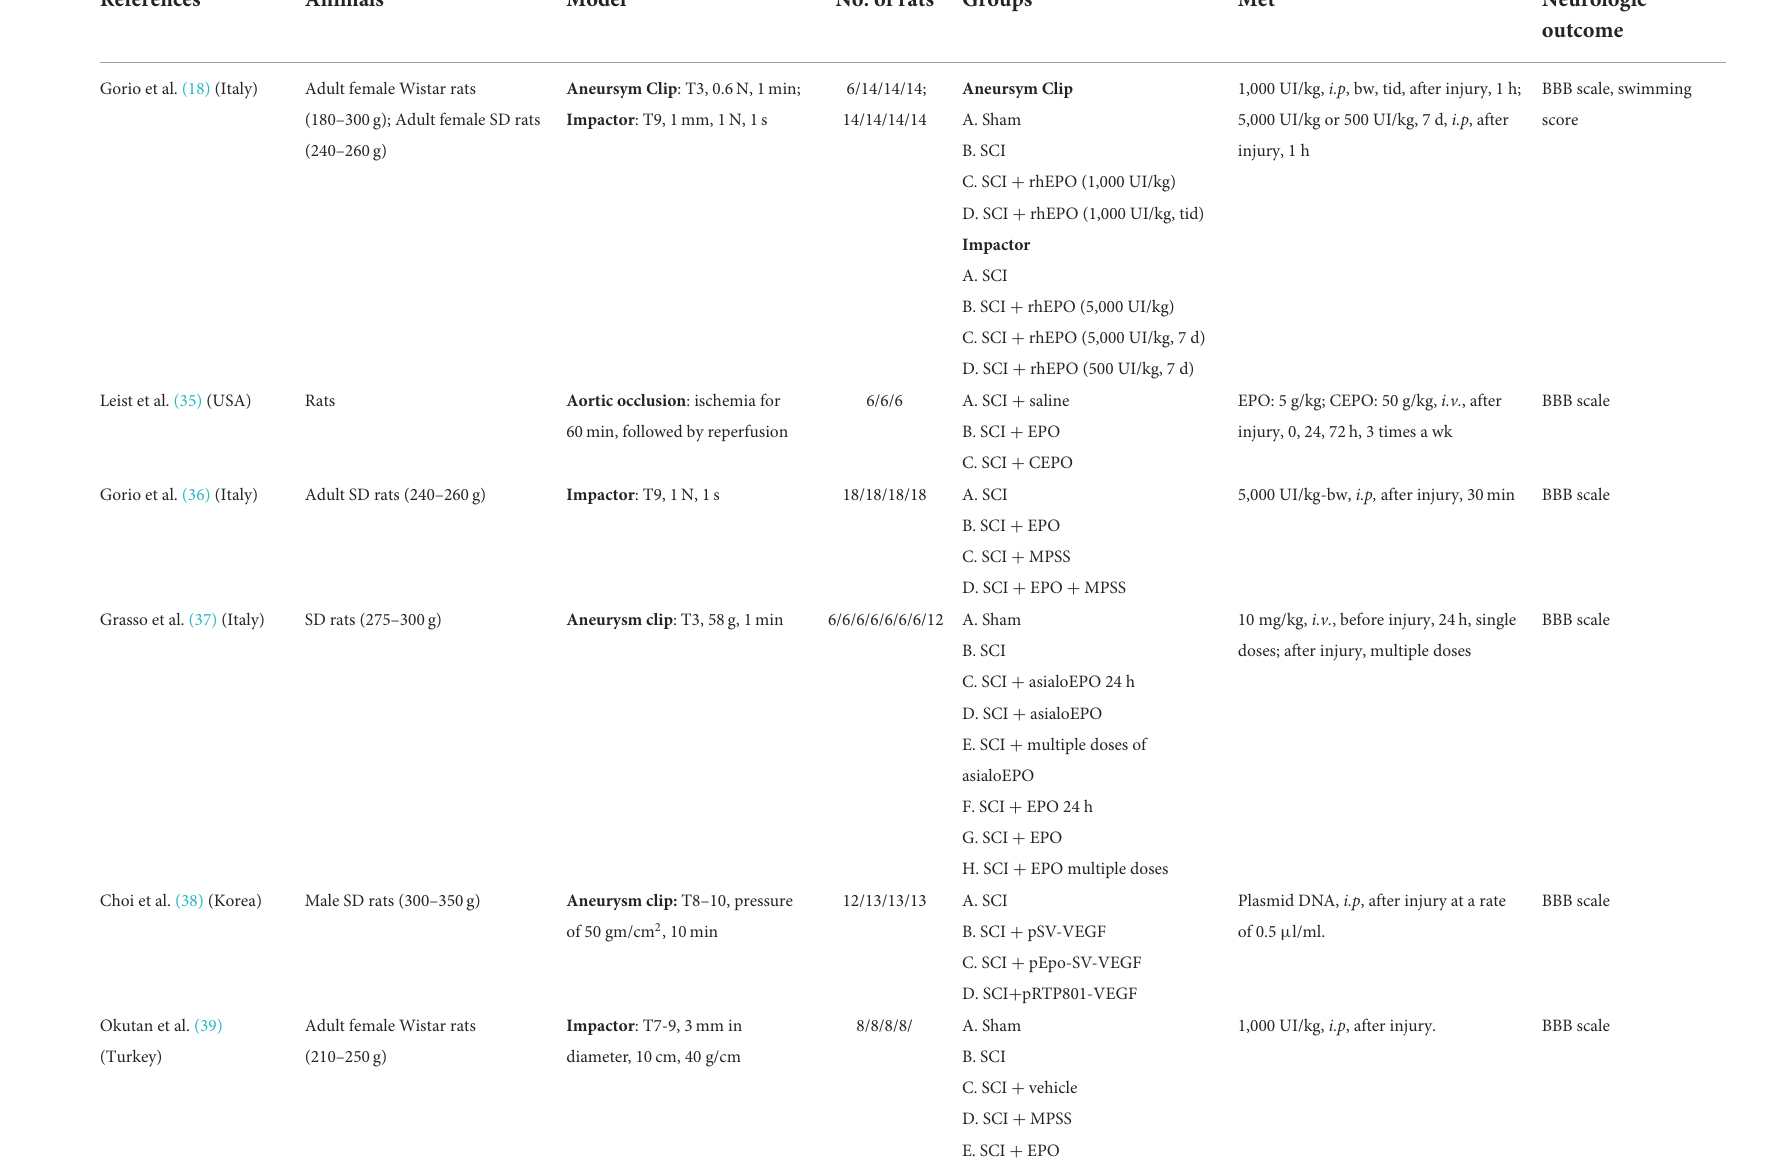
TABLE 1 Characteristics of the included